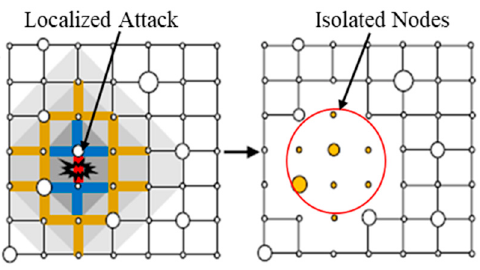
Figure 1. A typical aftermath of localized attacks [3].